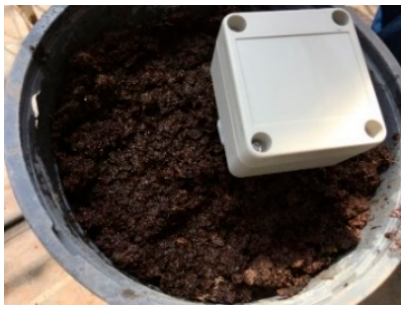
Figure 11. Soil water content measurement during calibration.